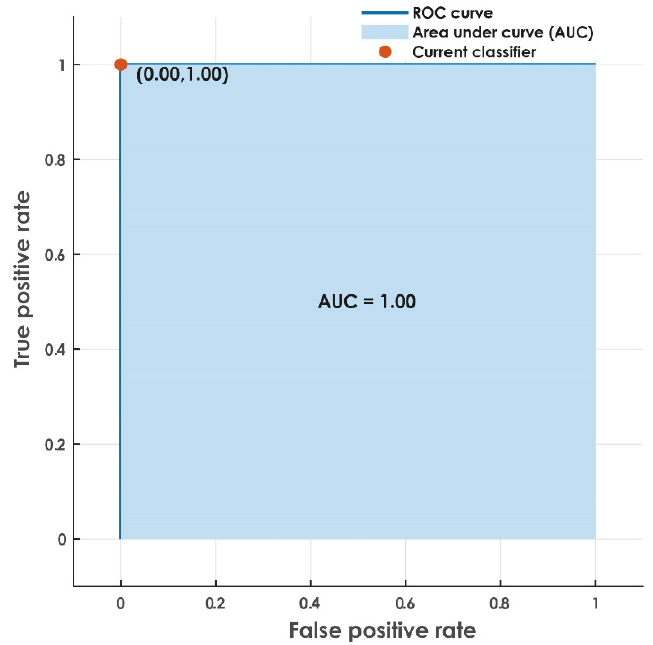
Figure 13. Receiver operating characteristic (ROC) curve obtained for the proposed approach.